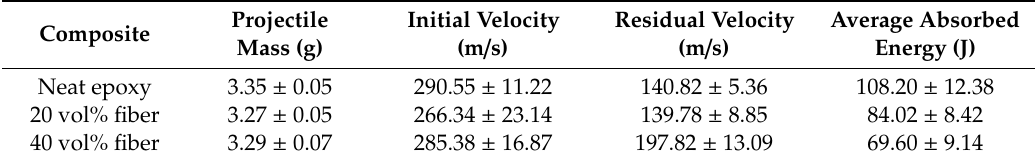
Table 3. Ballistic test data with .22 ammunition.